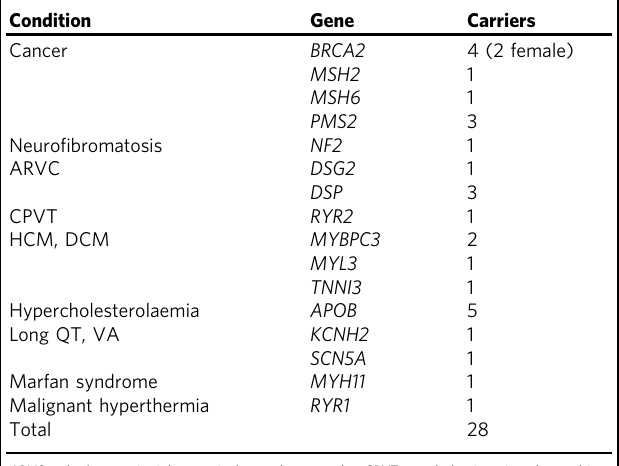
Table 2 Counts of clinically signi fi cant small variation in the MGRB for all genes in the ACMG SF 2.0